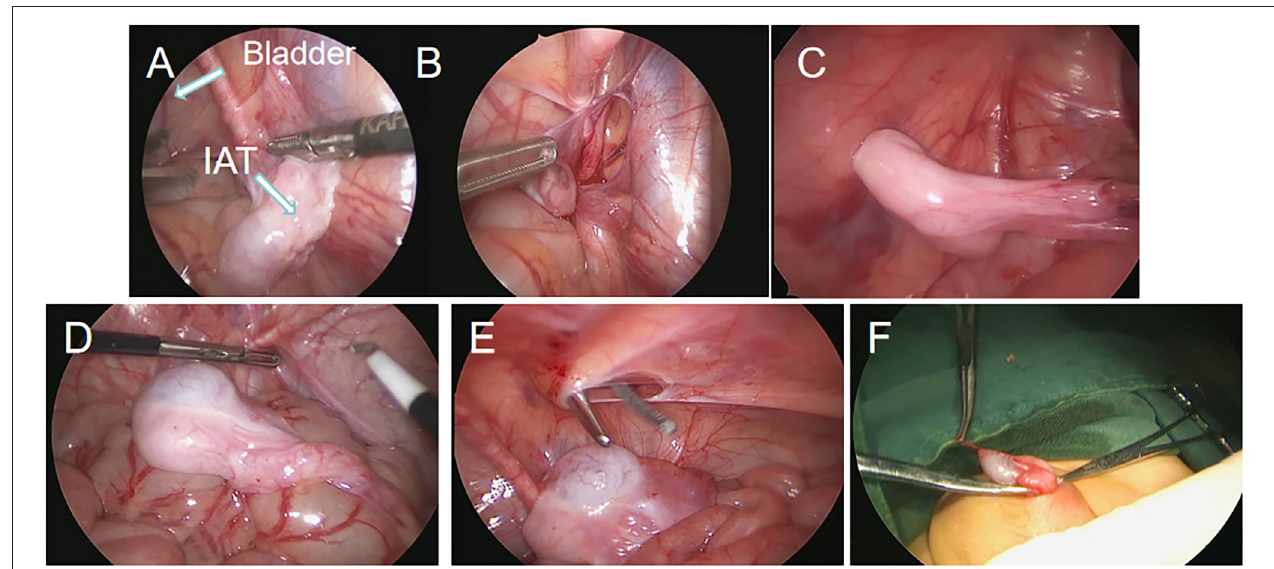
FIGURE 1 | Screenshots of laparoscopic testicular traction and fixation by the Shehata technique. (A) Laparoscopy showed high intra-abdominal testes. (B) The spermatic vessels of the testes were dissociated. (C) The testes were fixed on the opposite abdominal wall. (D–F) The second stage of operation reduced the testis to scrotum and fixed the testes.